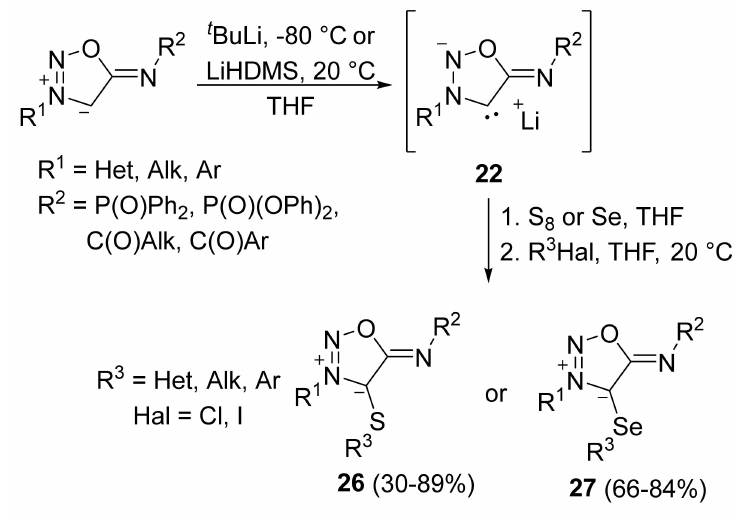
Scheme 16. Preparation of thioether and selenoether sydnone imines.